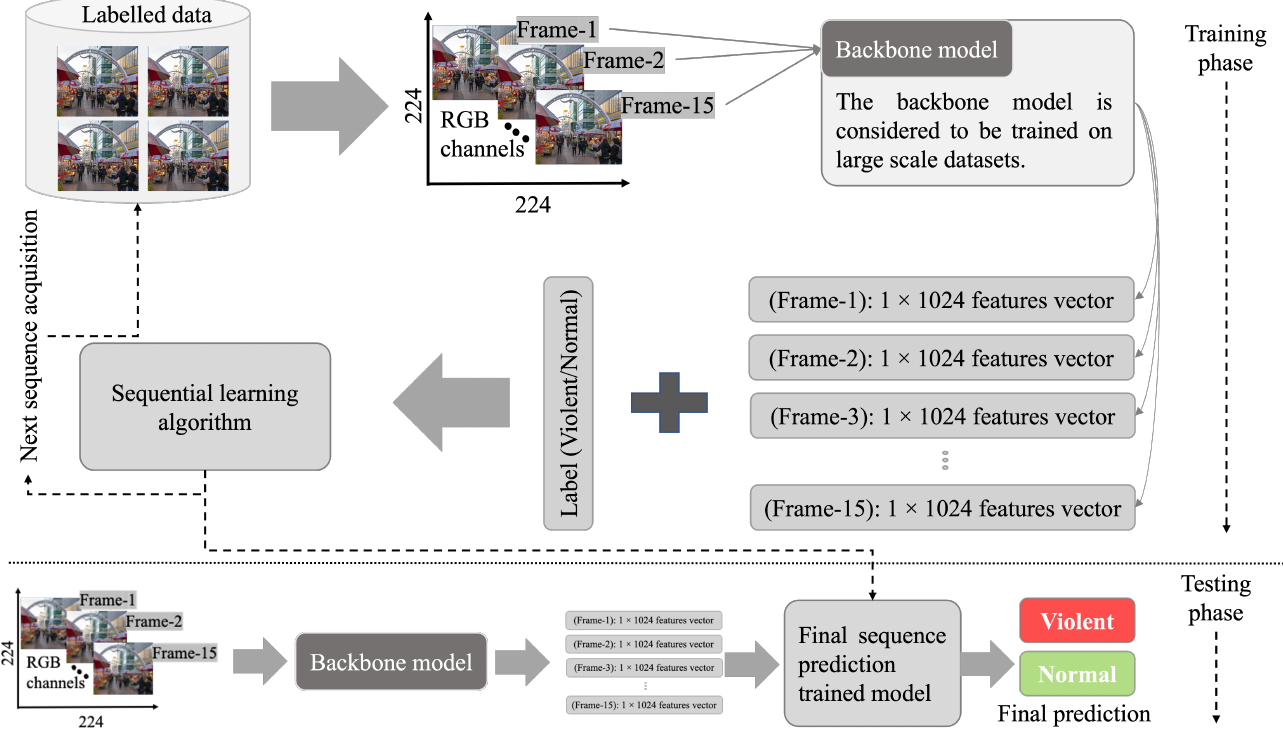
Figure 3. The overall training procedure of the proposed framework.